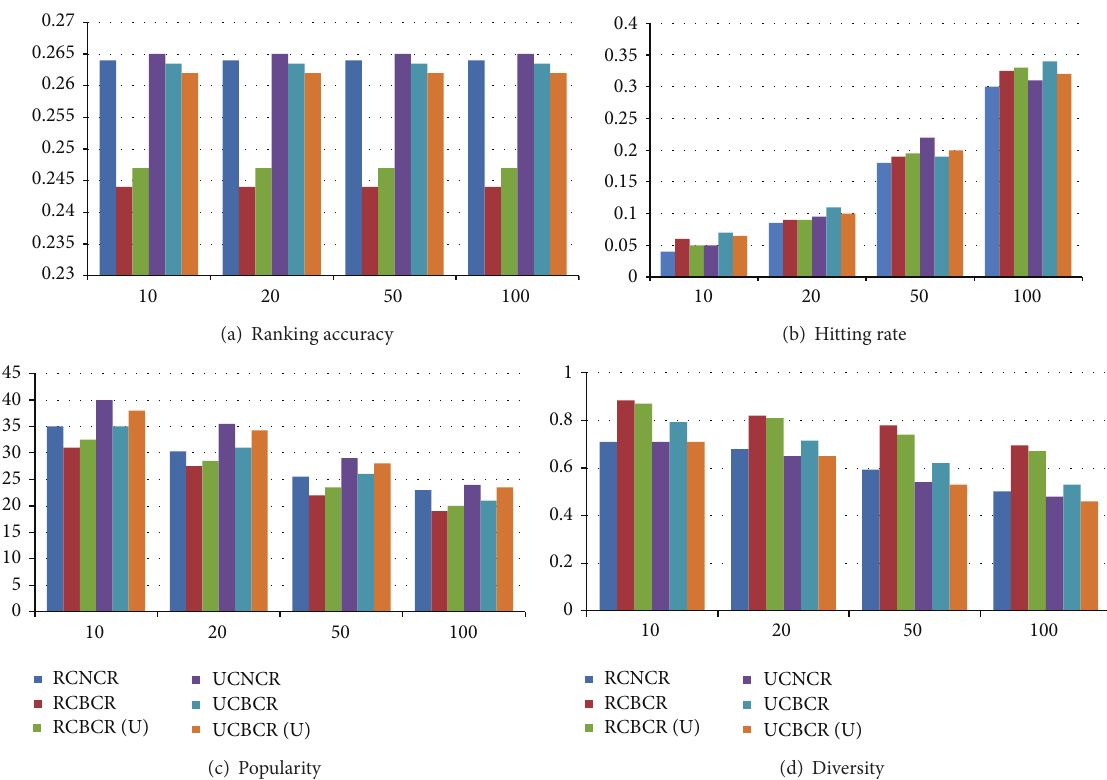
Figure 6: Results of different algorithms under some typical list lengths. (a), (b), (c), and (d) report the ranking accuracy, hitting rate, popularity, and diversity, respectively. The illustrations of RCBCR and UCBCR show the mean of all metrics UCBCR and RCBCR algorithms based on communities in Figure 4. And the illustrations of RCBCR (U) and UCBCR (U) show those results based on communities in Figure 5.